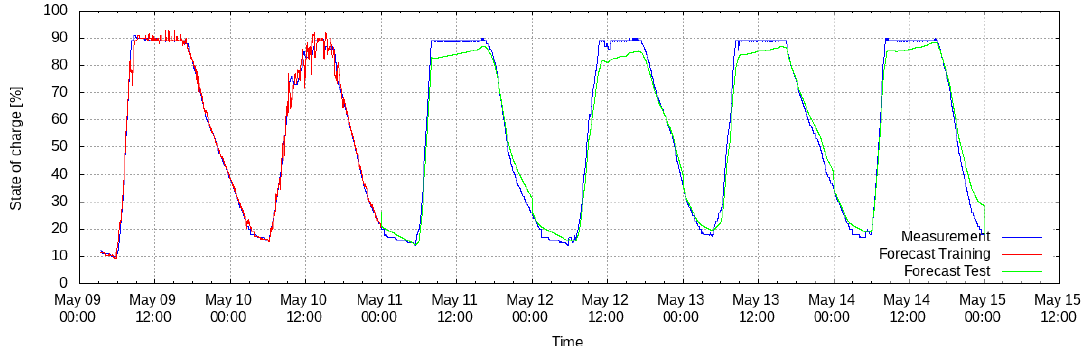
Figure 6. Model of degree one for the state of charge of a battery storage device. The measured data are depicted in blue, the results of the forecast by the model in the training period in red, and results of the iteratively computed forecast of the model in the testing period in green.